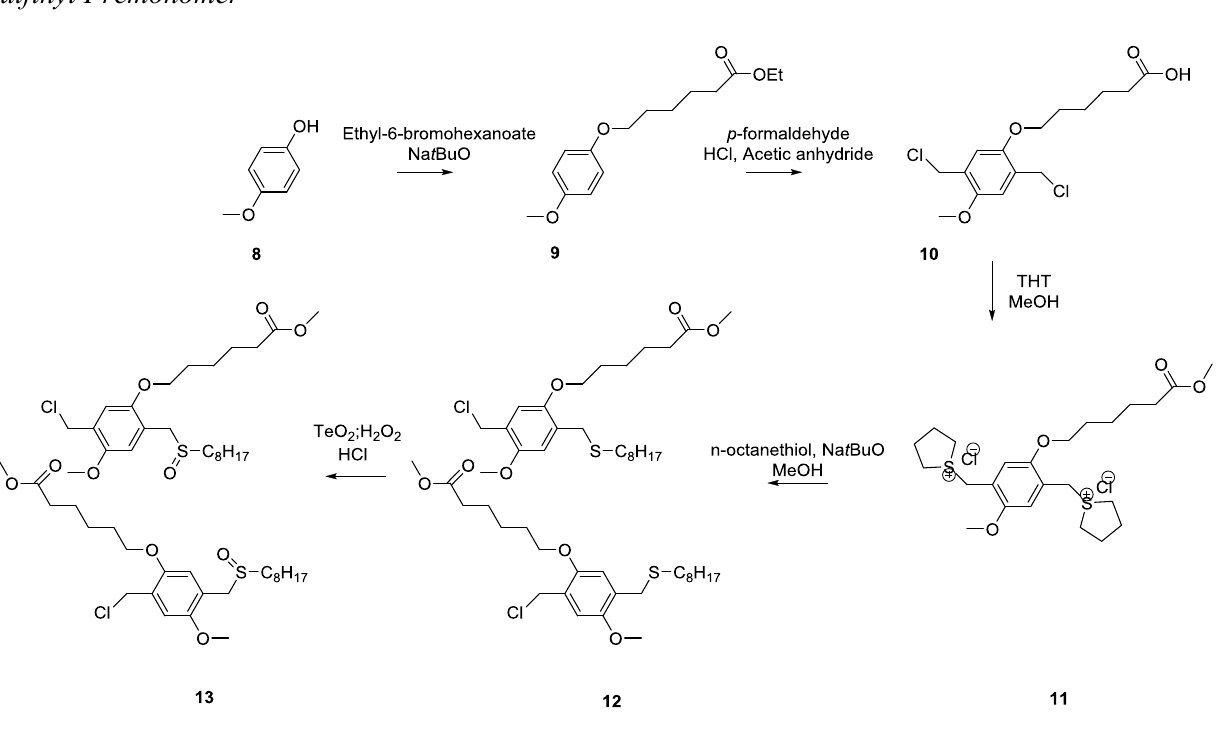
Scheme A2. Synthesis route for CPM premonomer via the sulfinyl precursor